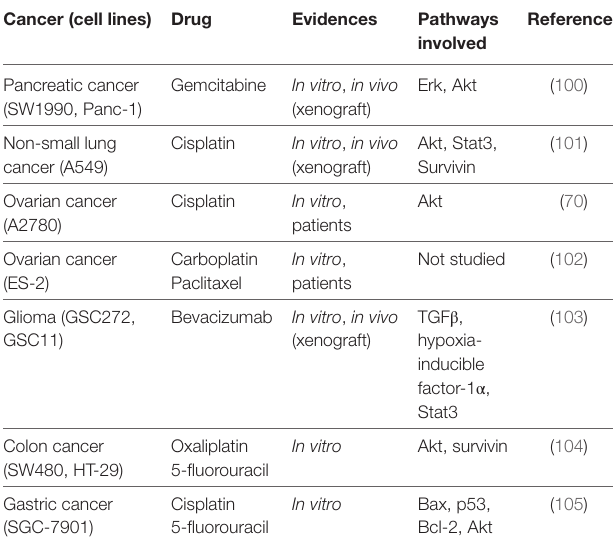
TAbLe 3 | Periostin and resistance to chemotherapy. Cancer (cell lines)